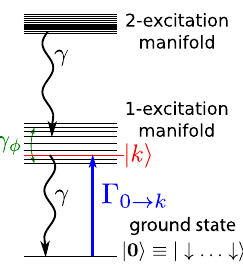
FIG. 2. Engineered qubit many-body spectrum. The nonequili- brium drive and the resulting photon fluctuation bath are used to create a dominant transition from the trivial ground state to a target entangled W state in the one-excitation manifold. The existence of a nonzero spontaneous decay γ is critical to avoid populating higher excited-state state of H σ is simply the separable state j 0 i ≡ j ↓ … ↓ i .